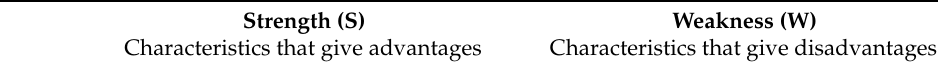
Table 10. The general outline of the SWOT (strength, weakness, opportunity, threat) analysis to be used for WTE (Waste-to-Energy) projects [38]. Strength (S) Weakness (W) Characteristics that give advantages Characteristics that give disadvantages Availability of land area, location of facility, proximity to other urban centers, quantity and characteristics of Municipal Solid Waste (MSW), capital cost, operation and Internal Factors maintenance cost, risk factor of acquiring the right kind of MSW, scope of public and private participation, availability of indigenous technology, existing environmental issues, scope for natural resources conservation, and scope for backward and forward of technological integration. Opportunity (O) Threat (T) Elements that can be exploited to provide Elements of the environment that bring barriers and trouble additional benefit External Factors Local constraints, political situation, climatic condition, land restriction criteria, existing socio-economic and market condition, availability of raw material for auxiliary fuel / additive, national and international regulations, and initial capital